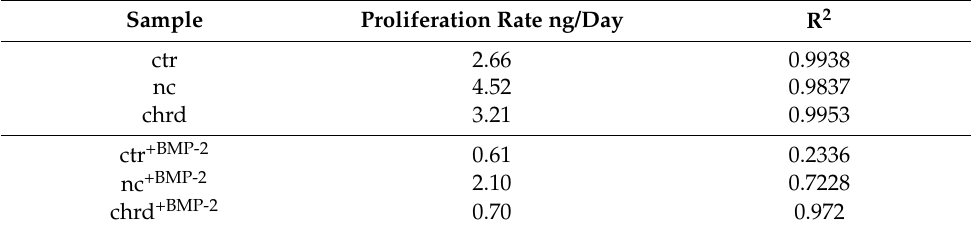
Table 3. Proliferation rates (increase DNA in ng per day) in microtissues from siRNA-loaded cGM and hMSC in an osteogenic medium with or without BMP-2 (ctr: non-treated control, nc: non-coding siRNA, chrd: chordin